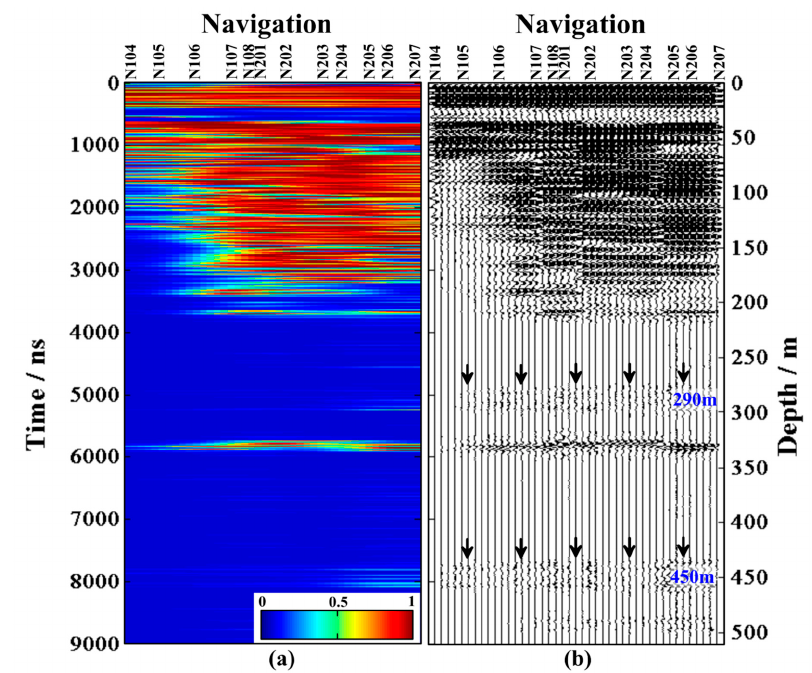
Figure 10. Demonstration of the extracted weak signal (with depth marked). ( a ) Local correlation map ( b ) Extracted signal using our method. Electronics 2019 , 8 , x FOR PEER REVIEW